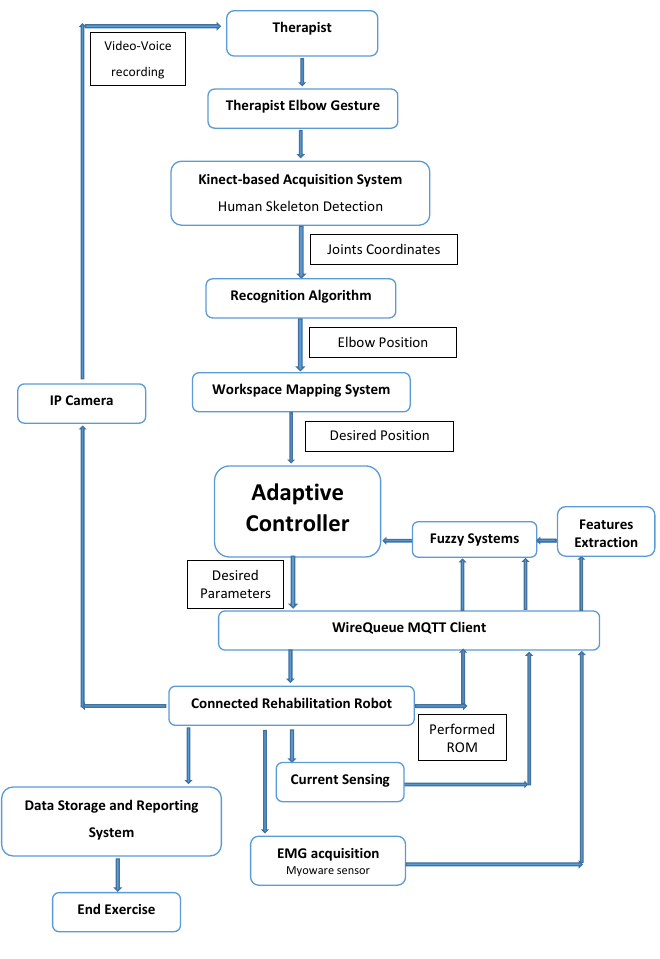
Figure 4. Operating system flowchart.